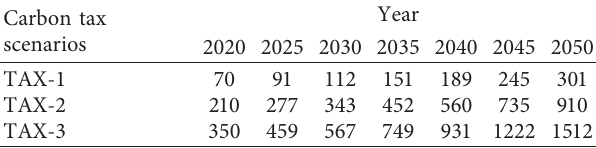
Table 2: Carbon tax rates set under different scenarios